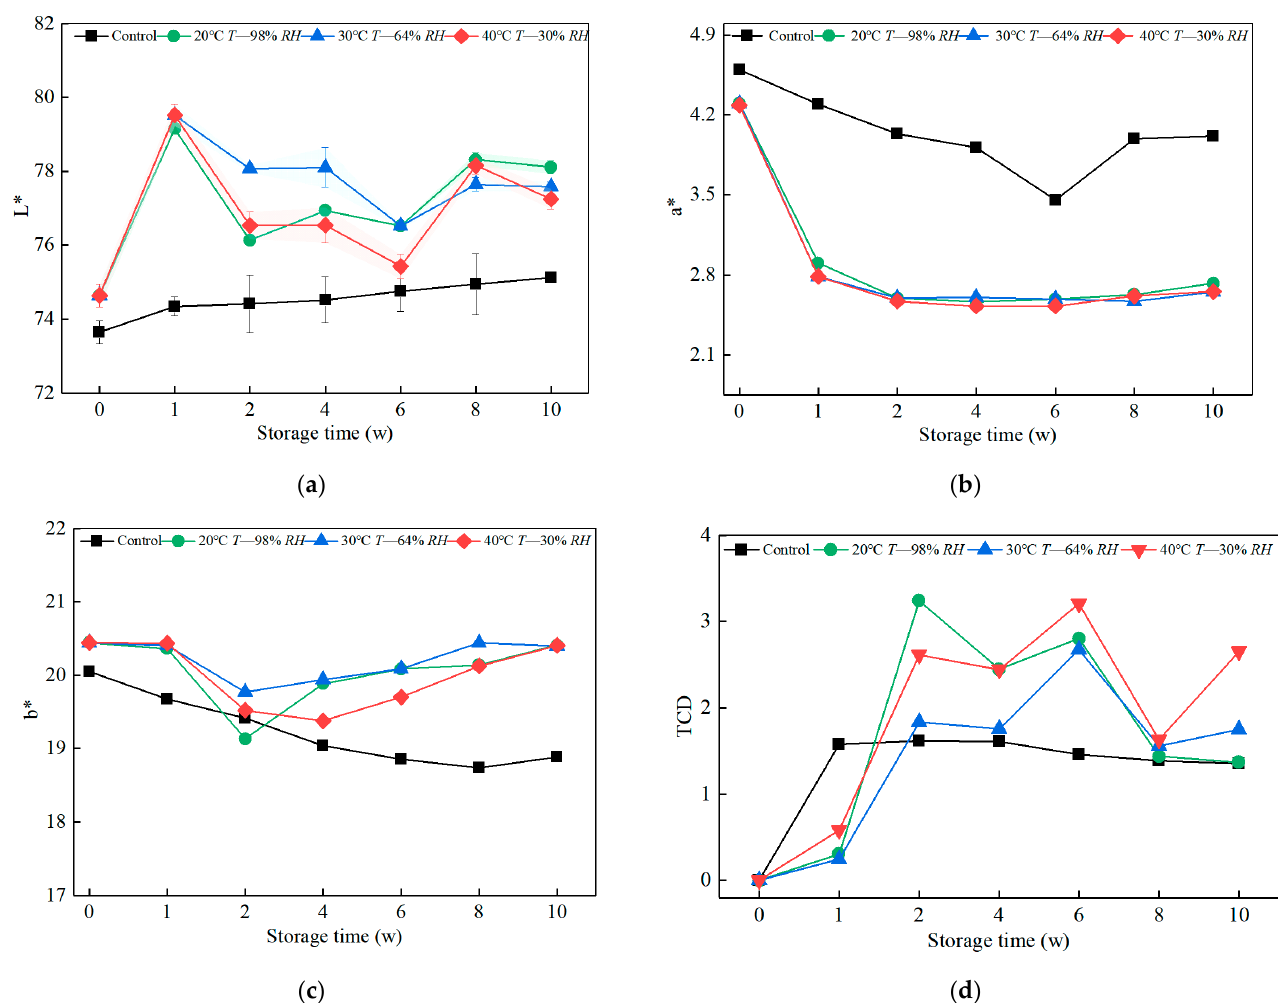
Figure 3. Effect of humidity and heat ageing on the color of bamboo pith. ( a ) Lightness values for Bamboo pith side of all samples. ( b ) Red/green values for Bamboo pith side of all samples. ( c ) Blue/yellow values for Bamboo pith side of all samples. ( d ) Total color difference value for Bamboo pith side of all samples. Table 1. Humid heat cycle ageing data records on bamboo weight response. Ageing Cycle (Weeks)